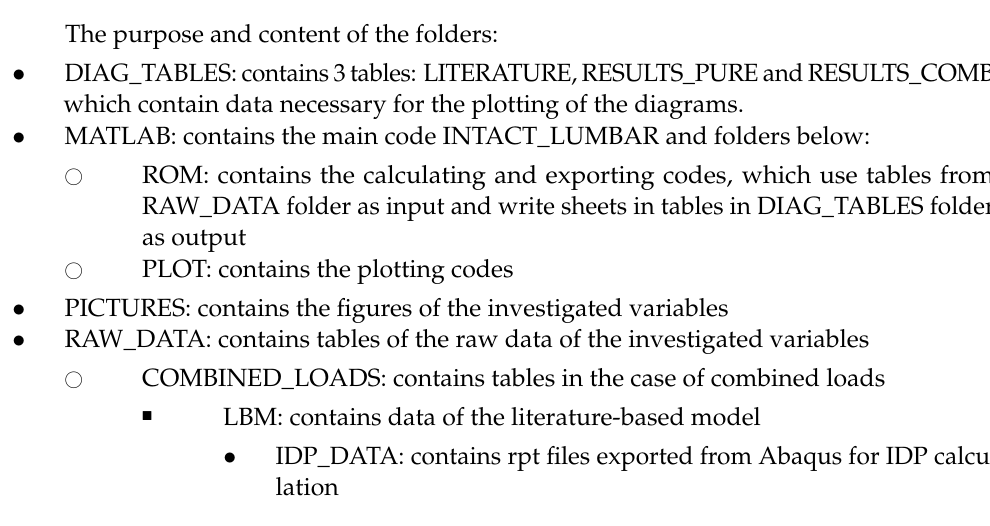
Figure A4. Folder Structure.